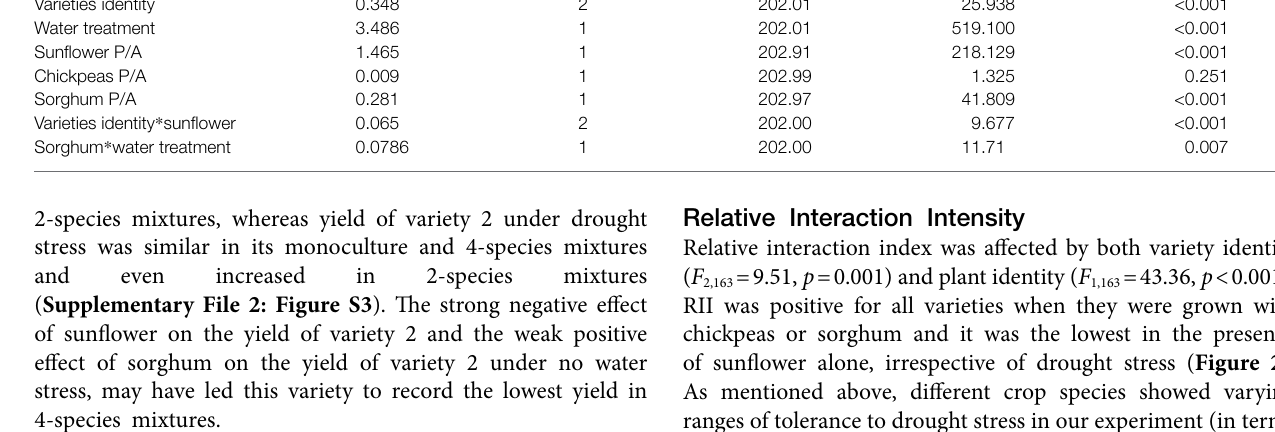
( Supplementary File 2: Figure S3 ). The strong negative effect of sunflower on the yield of variety 2 and the weak positive effect of sorghum on the yield of variety 2 under no water stress, may have led this variety to record the lowest yield in 4-species mixtures.